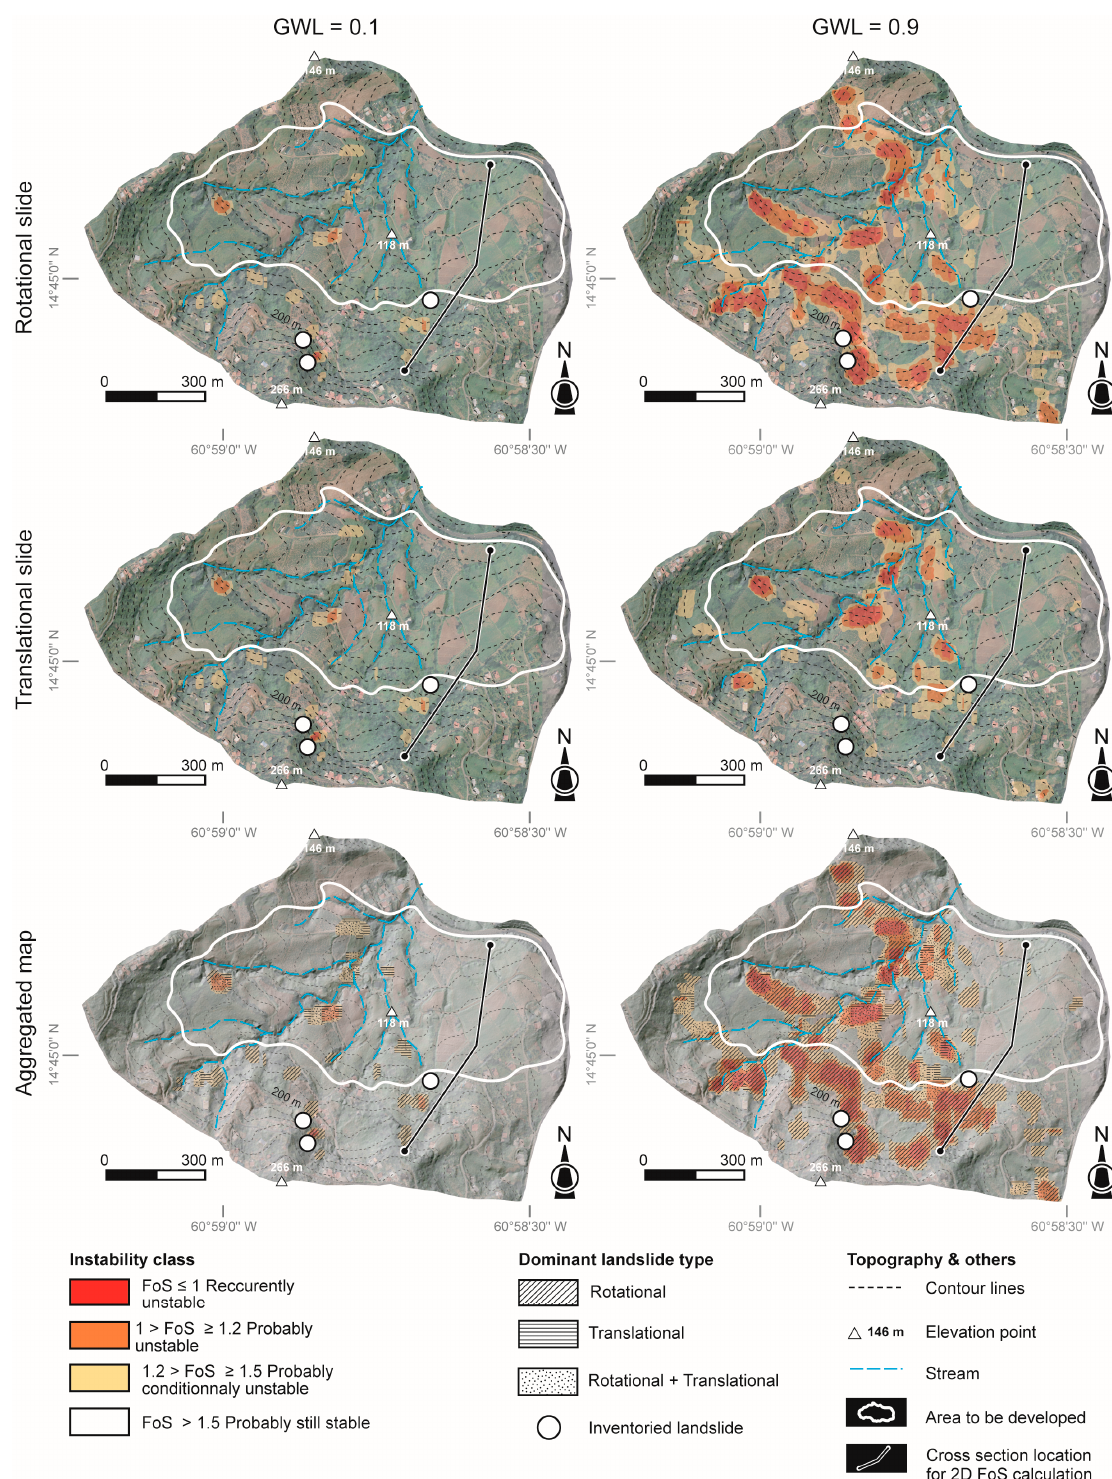
Figure 10. Slope stability maps obtained with ALICE ® for shallow landslides (translational + rotational) for dry and saturated conditions (coordinates are expressed in Lat/Long; projection WGS84 UTM 20N—EPSG 32620).